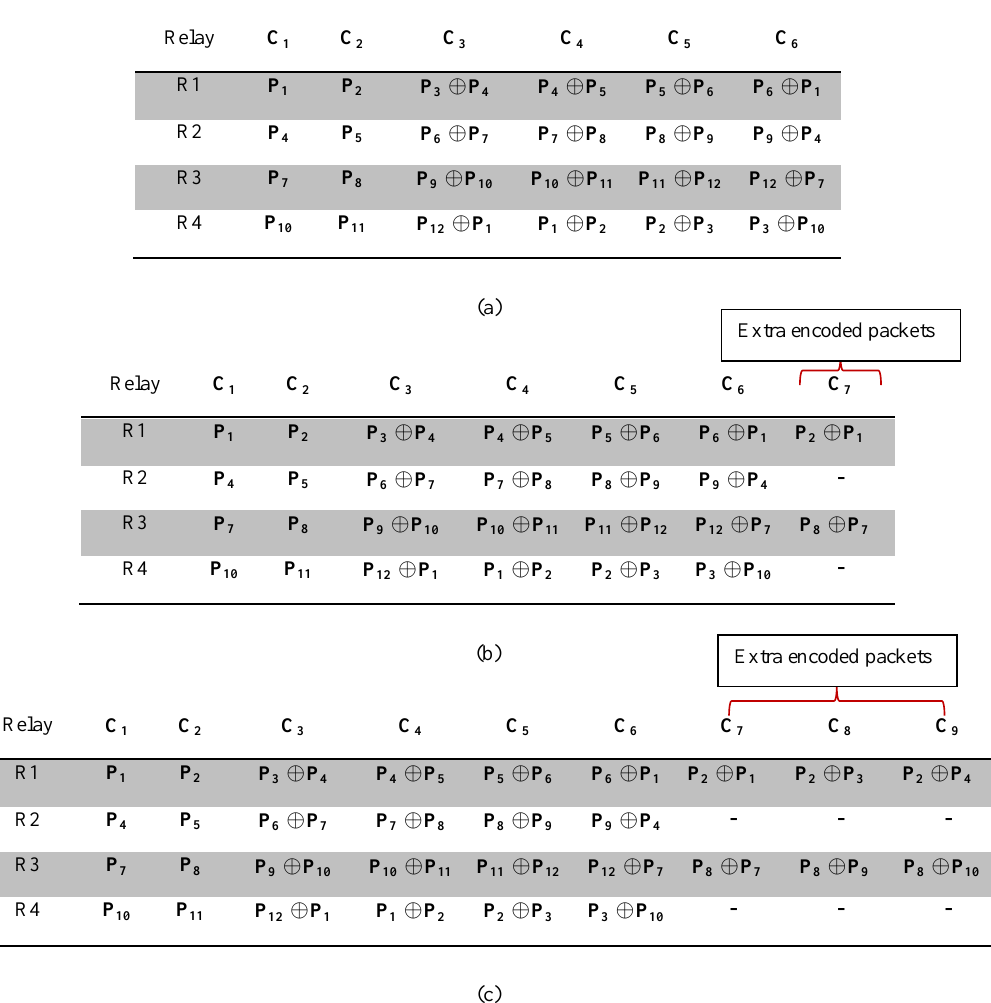
Figure 7. Packet coding schema for PER (in percentage) between ( a ) 0 – 18 , ( b ) 18 – 30 and ( c ) 40 – 45 for S2 and S8 as critical sensors.